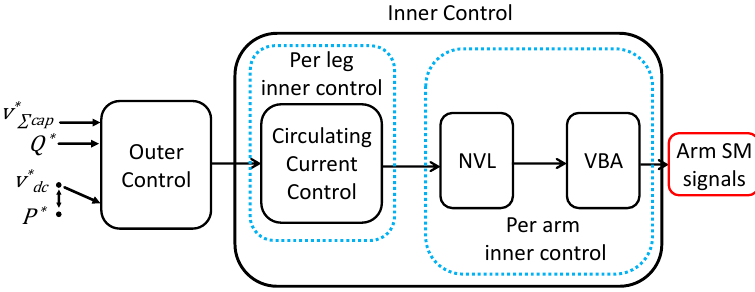
Figure 5. Control sequence of the FBMMC1 and FBMMC2. NVL: nearest voltage level; VBA: voltage balancing algoritm.